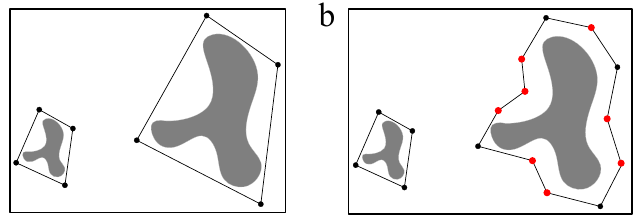
Figure 9. Schematic of connected paths and sampling points. ( a ) The connected paths in the roadmap are constructed only with shape points. ( b ) The connected paths in the roadmap are constructed with shape points and distance points.